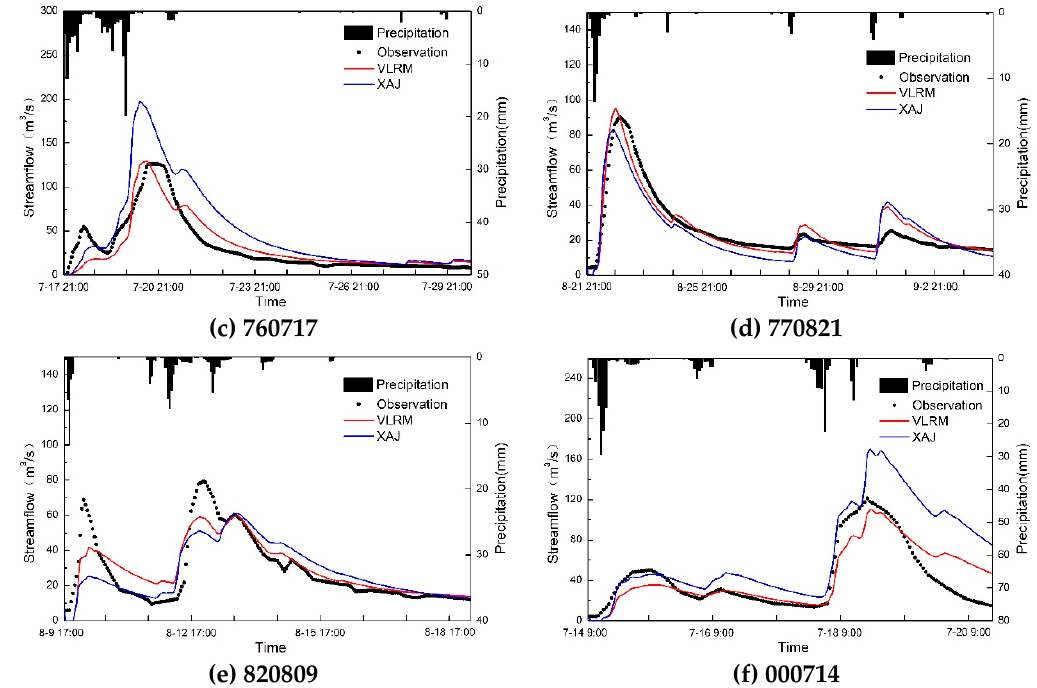
Figure 6. Comparisons of observed and simulated streamflows for typical flood events in Xiuwu basin in panels ( a ), ( b ) for calibration and ( c ), ( d ) for validation.